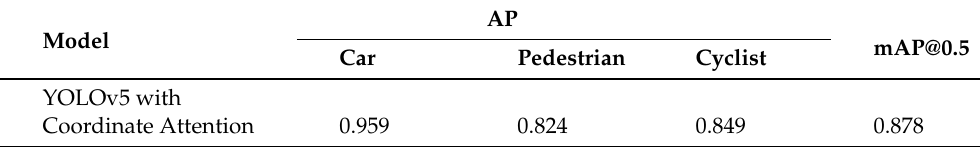
Table 3. The recognition results of YOLOv5s with Coordinate Attention in KITTI dataset.